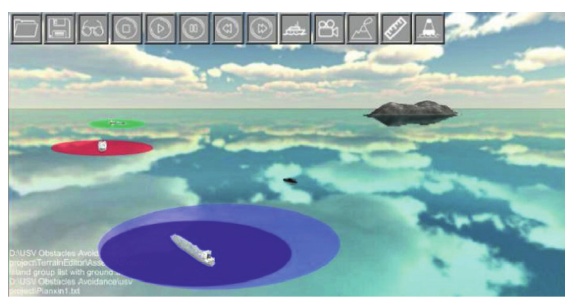
Figure 8: The collision avoidance process displayed by Unity3D.